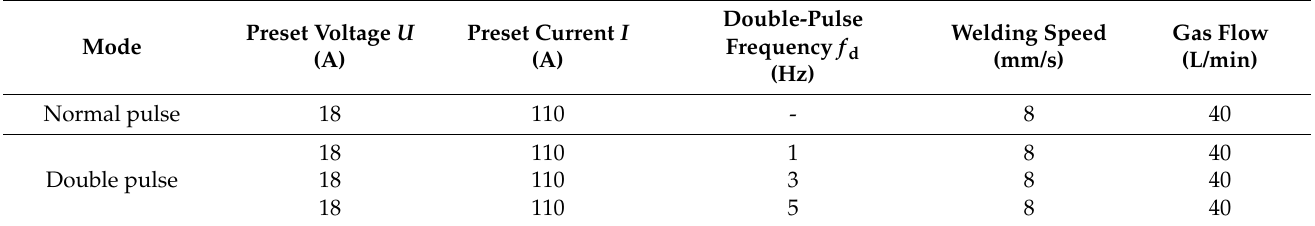
Table 3. Welding parameters for the normal-pulse and double-pulse, triple-wire MIG processes.